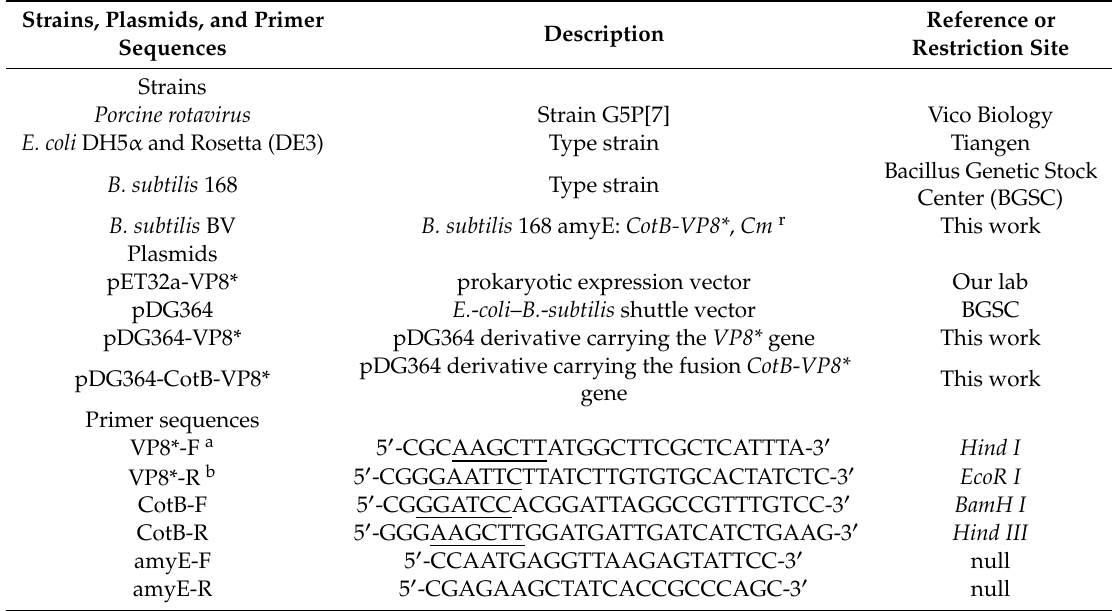
Table 3. Plasmids and primers